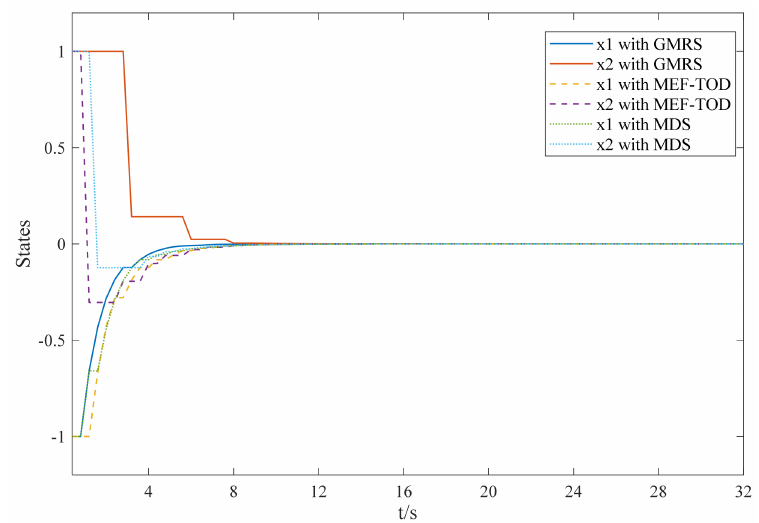
Figure 9. System performance